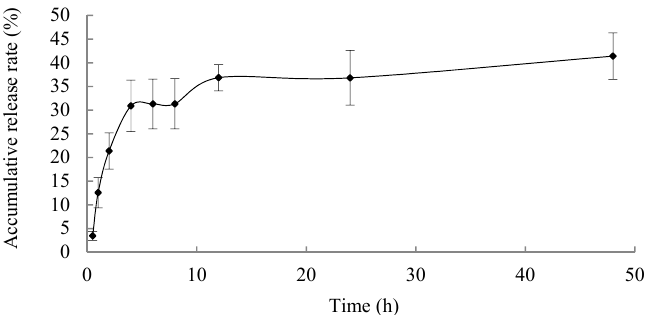
Figure 5. In vitro release study of berberine hydrochloride-loaded microspheres. Data are represented as mean ± SD ( n = 3, each group).